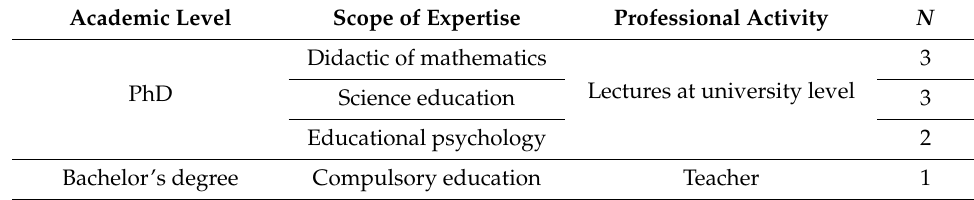
Table 2. Composition of the panel of experts that reviewed the appropriateness of the surveys involved in the